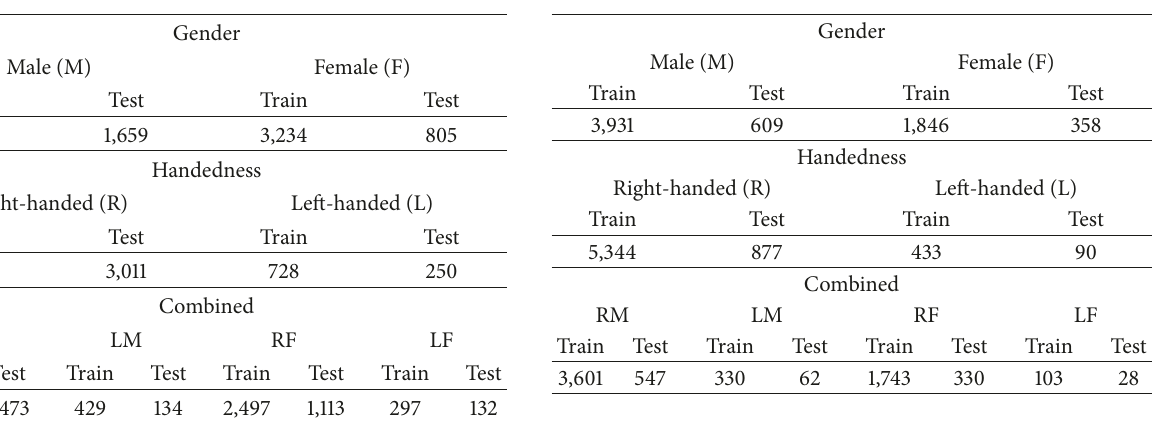
Table 2: Number of training and test lines used, per subclass and experiment, from KHATT